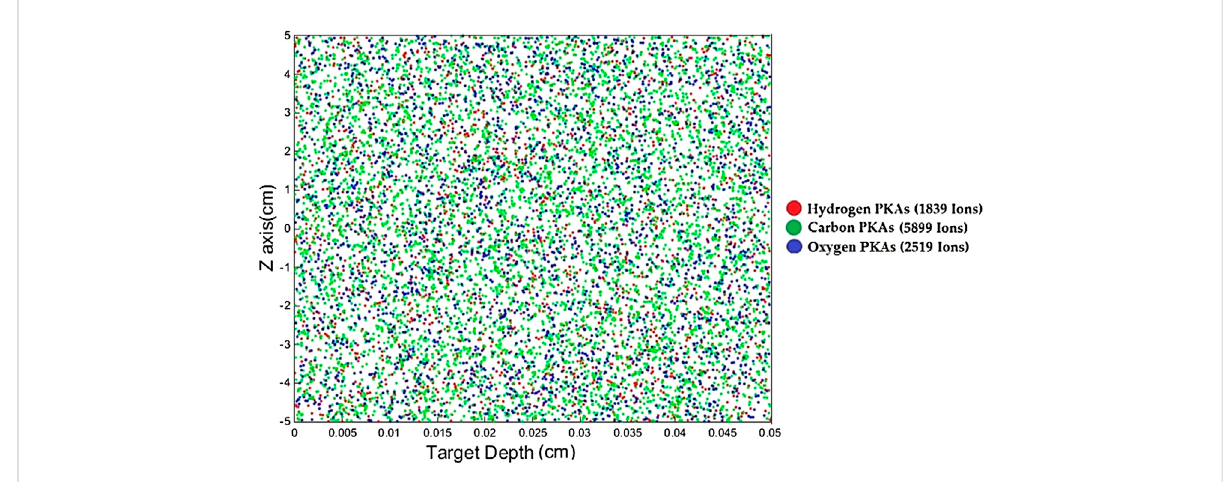
FIGURE 4 PKA ’ s 2D-distributions in PCL samples, sterilized with cobalt-60 gamma-ray source and 5 eV threshold energy by Monte Carlo method.